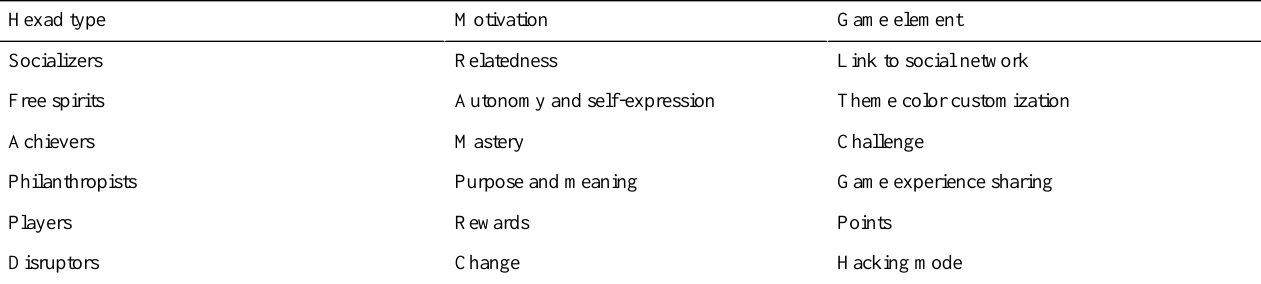
Table 2. The motivation and corresponding game elements added for each type of